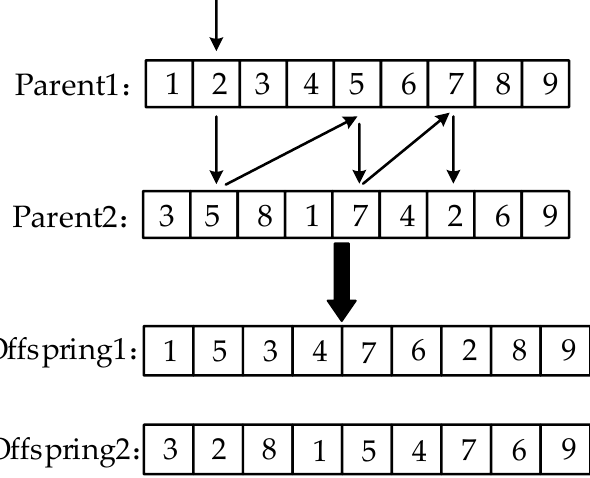
Figure 9. The operation process and results of CX.